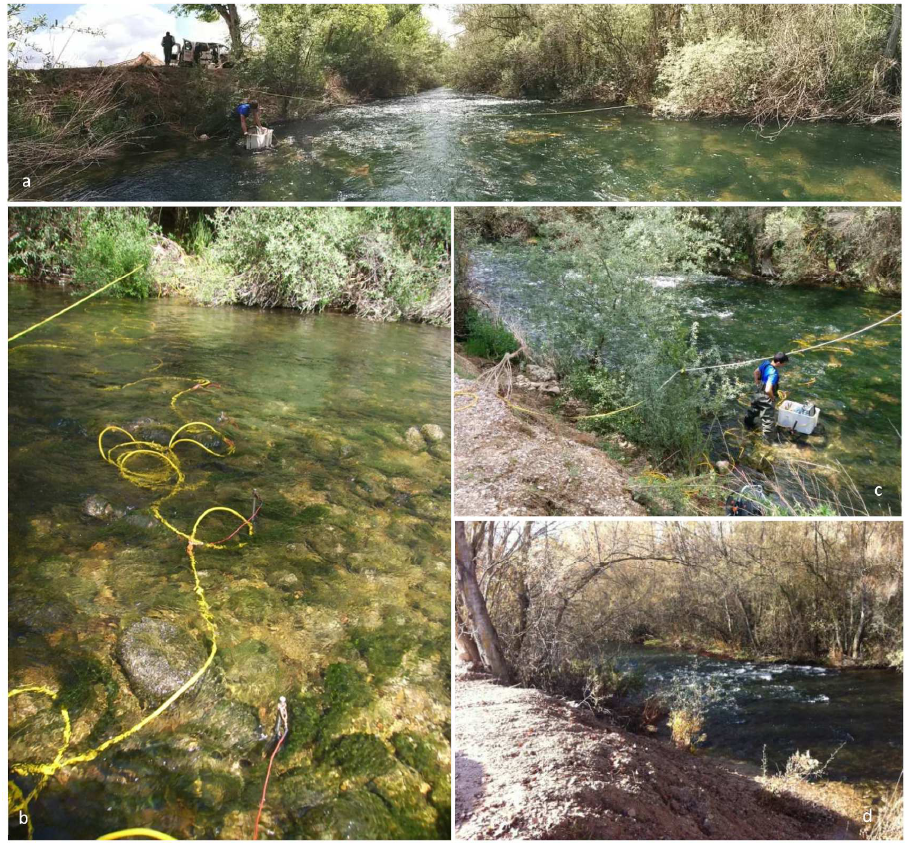
Figure 3. Pictures showing the main features of the investigated sites; ( a – c ) Heras de Ayuso (Site 1, HEN, Henares River), ( d )Romanones (Site 2, TAJ, Tajuna River).